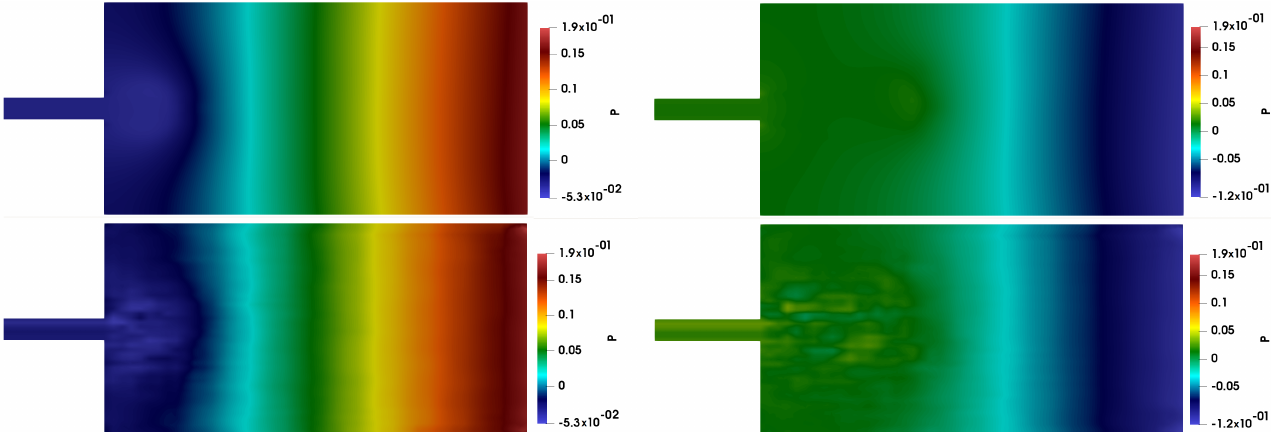
Figure 10. (Classical VAE) On the top, the high-fidelity second component of the velocity fields for the two time steps 499 and 998. On the bottom, the decoder outputs for the two time steps 499 and 998 at the final 4000-th epoch of the training phase.